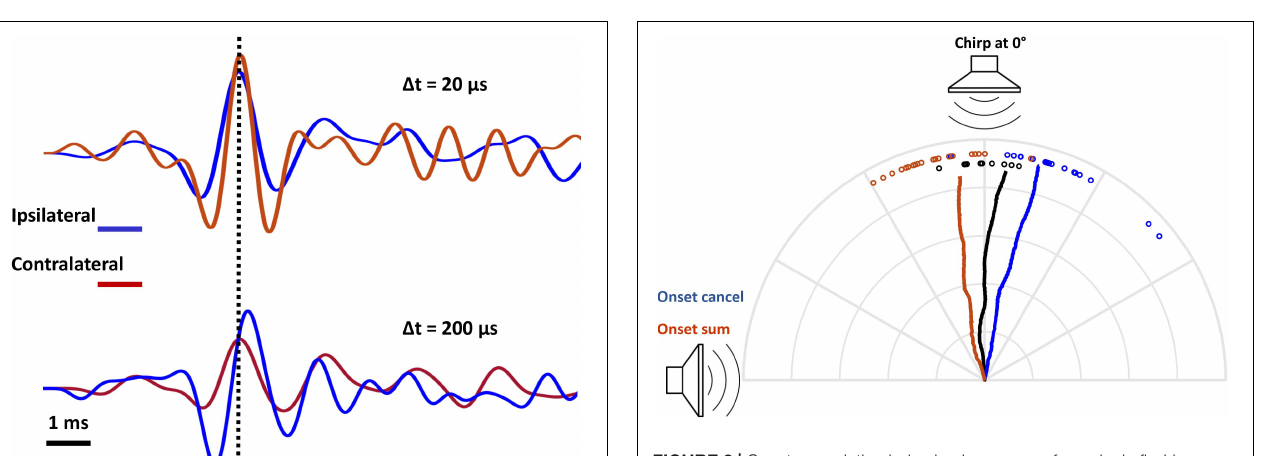
FIGURE 8 | Onset-cancelation behavioral responses for a single fly. Lines represent average ( n = 10) walking paths (grid = 0.5 cm); symbols show the individual response angles (as in Figure 4 ). Flies walk forward, toward an attractive acoustic stimulus located on midline (0 ◦ azimuth, black trace). When impulses broadcast from a lateral location ( ± 90 ◦ azimuth) are timed to cancel the onset of the attractive stimulus pulses, flies’ responses are in the direction contralateral to the impulse source (blue line, 0 ◦ alone vs. 0 ◦ + cancel: Watson’s U = 0.6626, p < 0.001). Reversing the phase of the impulses (so that they sum, rather than cancel the attractive pulse onsets) causes the flies’ responses to be oriented toward (ipsilateral to) the impulse source (red line, 0 ◦ alone vs. 0 ◦ + sum: Watson’s U = 0.5016, p <